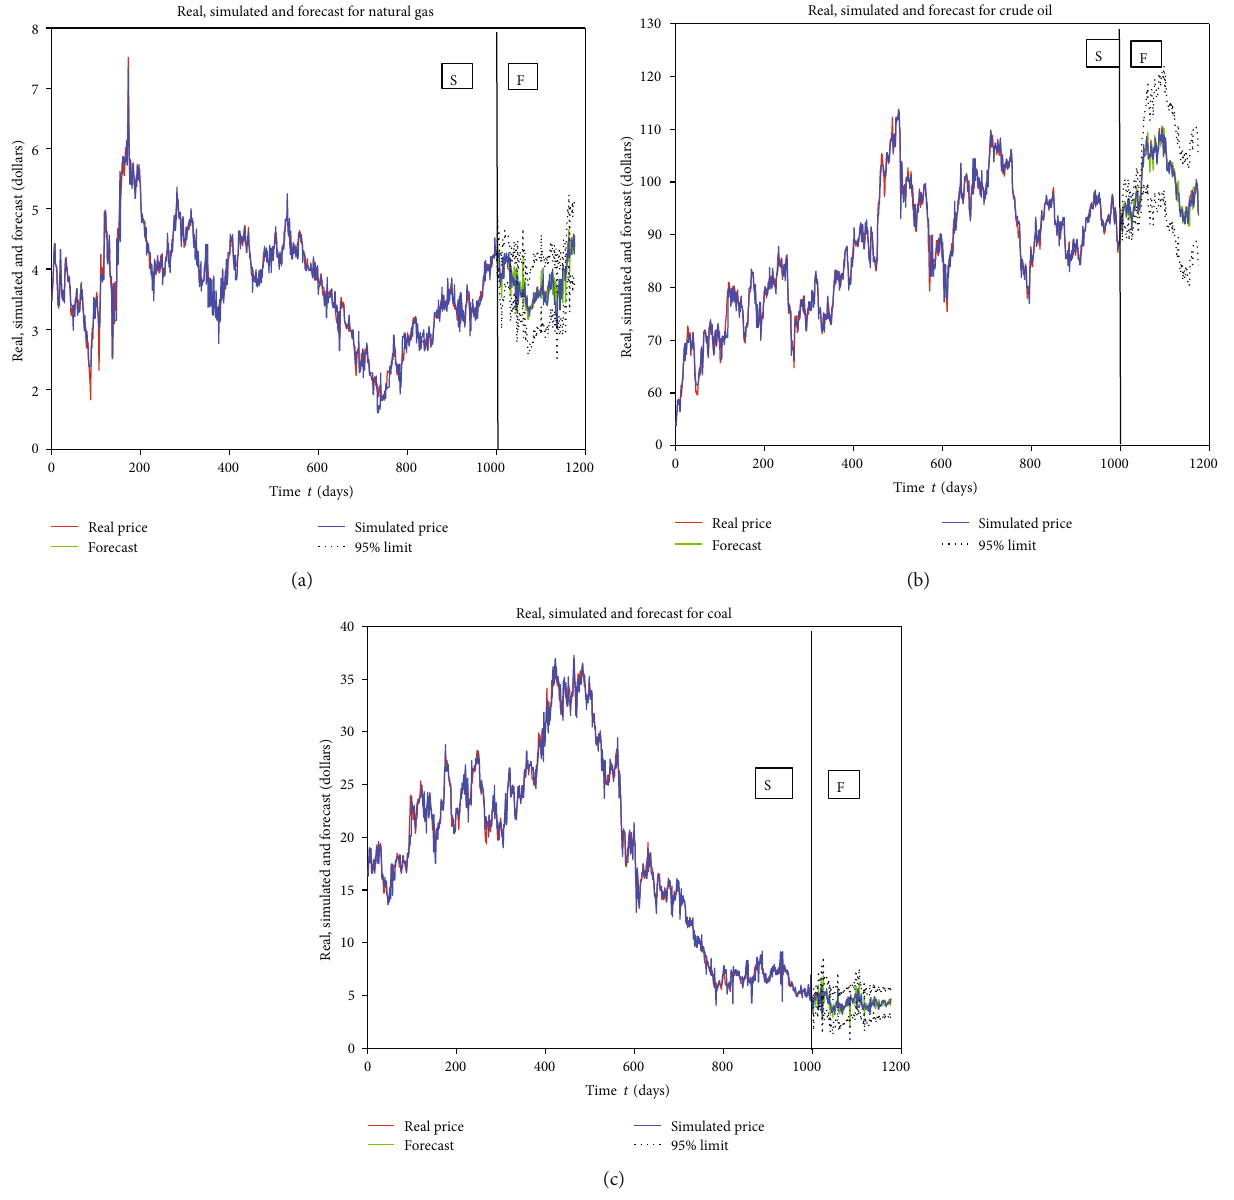
Figure 16: Real, simulated, forecasted prices and 95% CI with